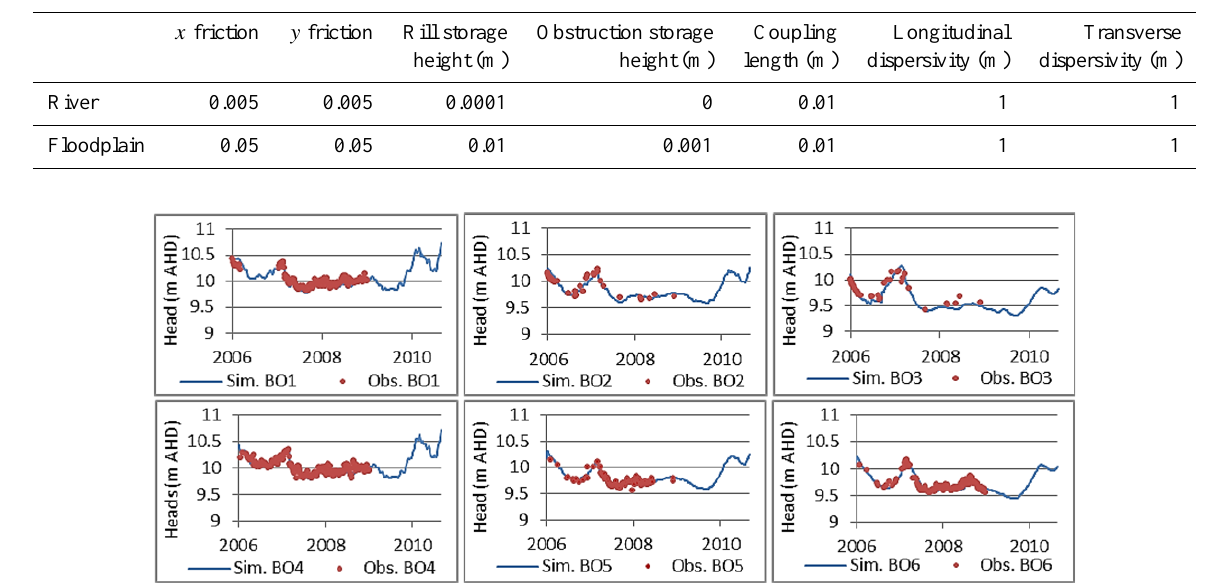
Table 2. Surface properties values of the numerical model.